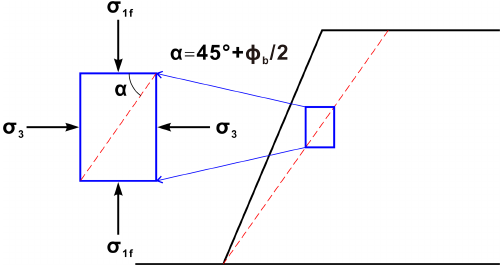
Figure 7. Schematic map showing the angle ( α ) for slopes steeper than 60 ◦ . σ 1 f and σ 3 are the major and minor principal stress in the state of limit equilibrium, respectively. φ b is the basic friction angle.